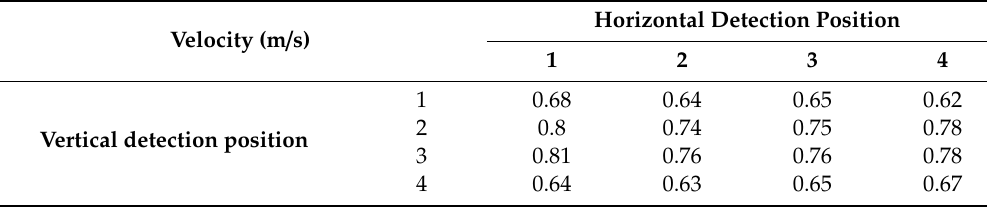
Table 2. Test results of the hood face velocity.